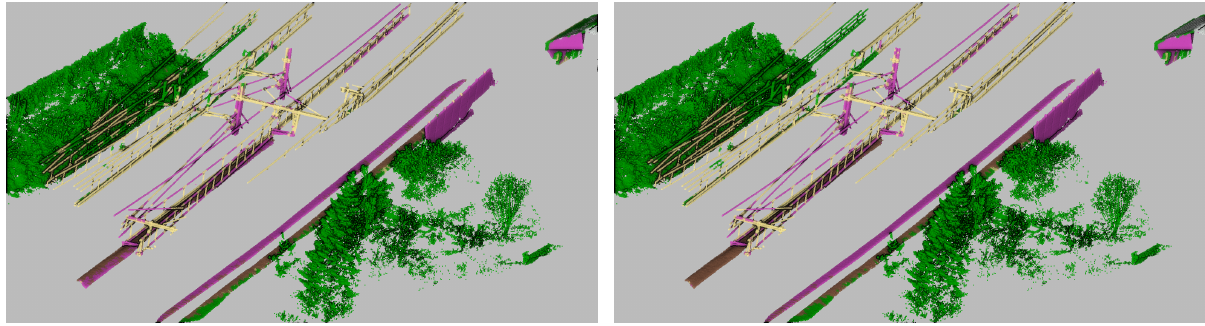
Figure 3. Classification results for 5 classes: vegetation (green), ballast (brown), linear objects (yellow), walls & fences (pink) and other (white). The scene is part of an acquisition along rail tracks, where tracks and ballast are visible in the middle, linear objects on the top, and vegetation, walls & Fences and other objects are mostly on the sides. Figure 3a displays the ground truth. Figure 3b shows the segmentation, where each color stands for a different region. Figures 3c, 3e and 3g present the pointwise classification with respectively no regularization, a regularization based on the 20, and on the 80 nearest neighbors. Figures 3d, 3f and 3h display the same experiments but using a pre-segmentation step. Major improvements from our method compared to the non-regularized Random Forest are seen mostly on linear